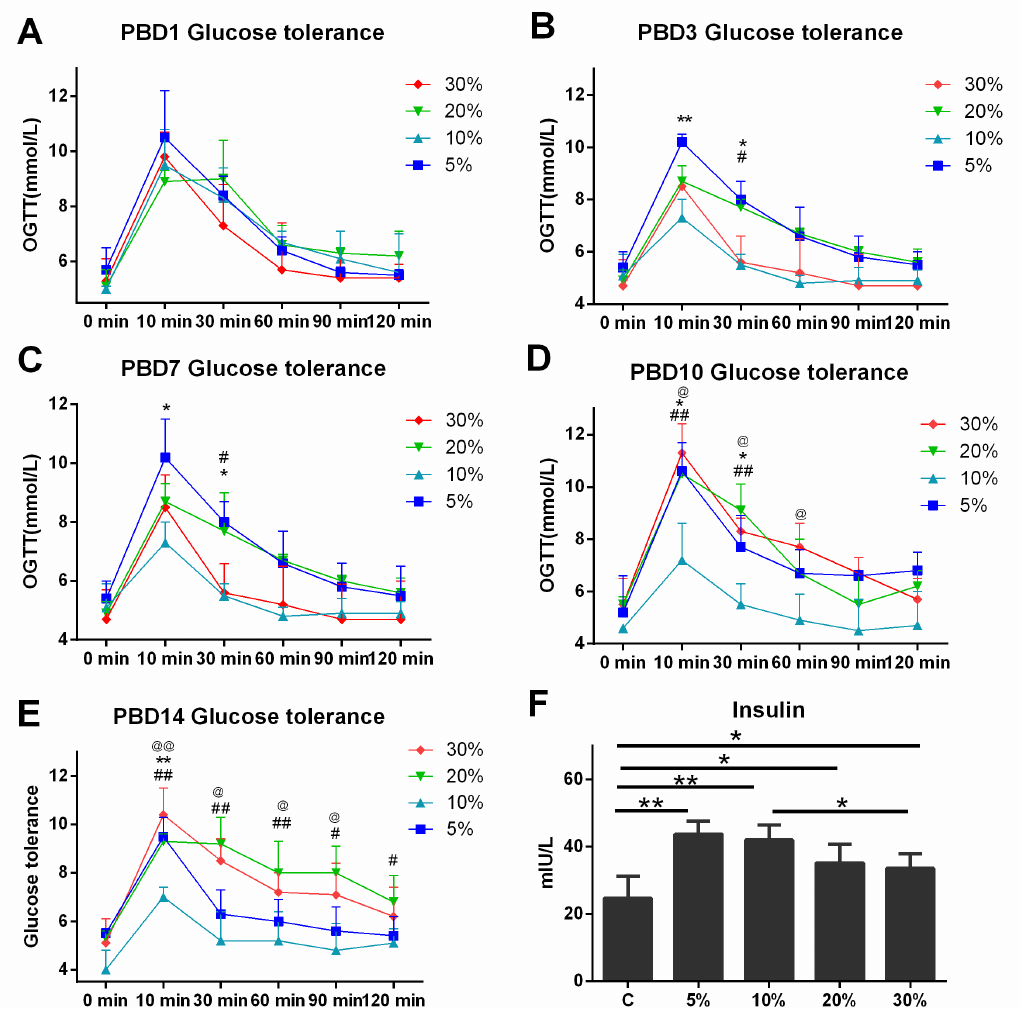
Figure 3. Effects of different carbohydrate–fat ratios on glucose tolerance and insulin levels in rats. Glucose tolerance level measurements revealed no significant differences between the groups after 1 day post-burn ( A ); after 3–14 days post-burn ( B – E ), the 10% group was able to induce a rapid recovery of blood glucose, which was significantly different compared to the 5%, 20% and 30% groups. After 14 days of burn injury, insulin was significantly higher in the 20% and 30% groups compared to the 5% and 10% groups ( F ). n = 6 per group, 5% group vs. 10% group, * p < 0.05, ** p < 0.01; 20% group vs. 10% group, # p < 0.05, ## p < 0.01; 30% group vs. 10% group, @ p < 0.05, @@ p < 0.01; PBD: post-burn day.